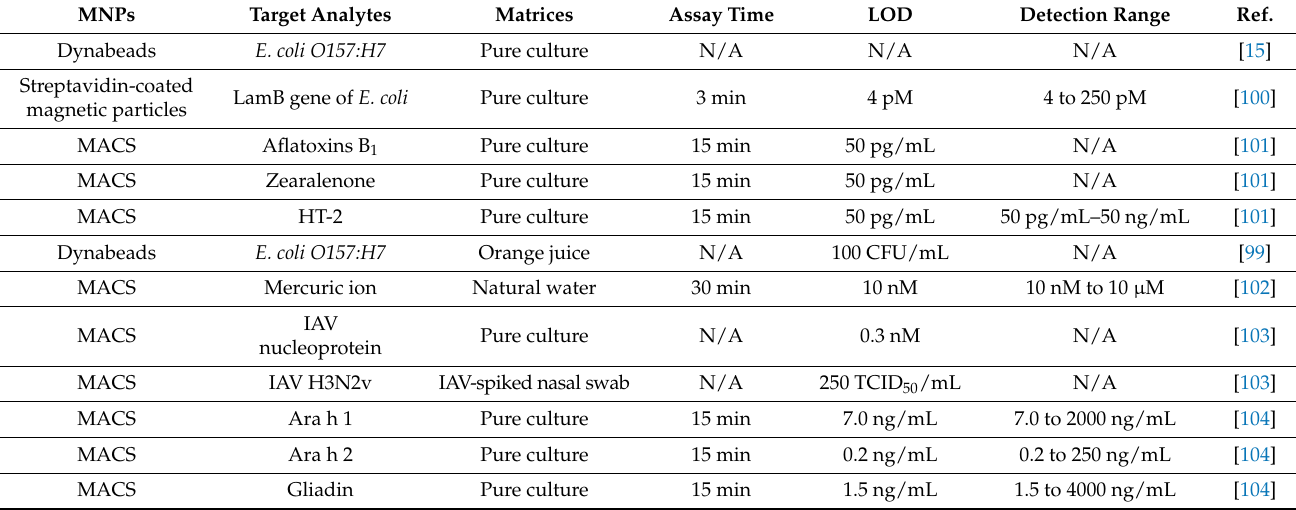
Table 2. Summary of GMR Biosensors for Food-related Biomarkers Detection.